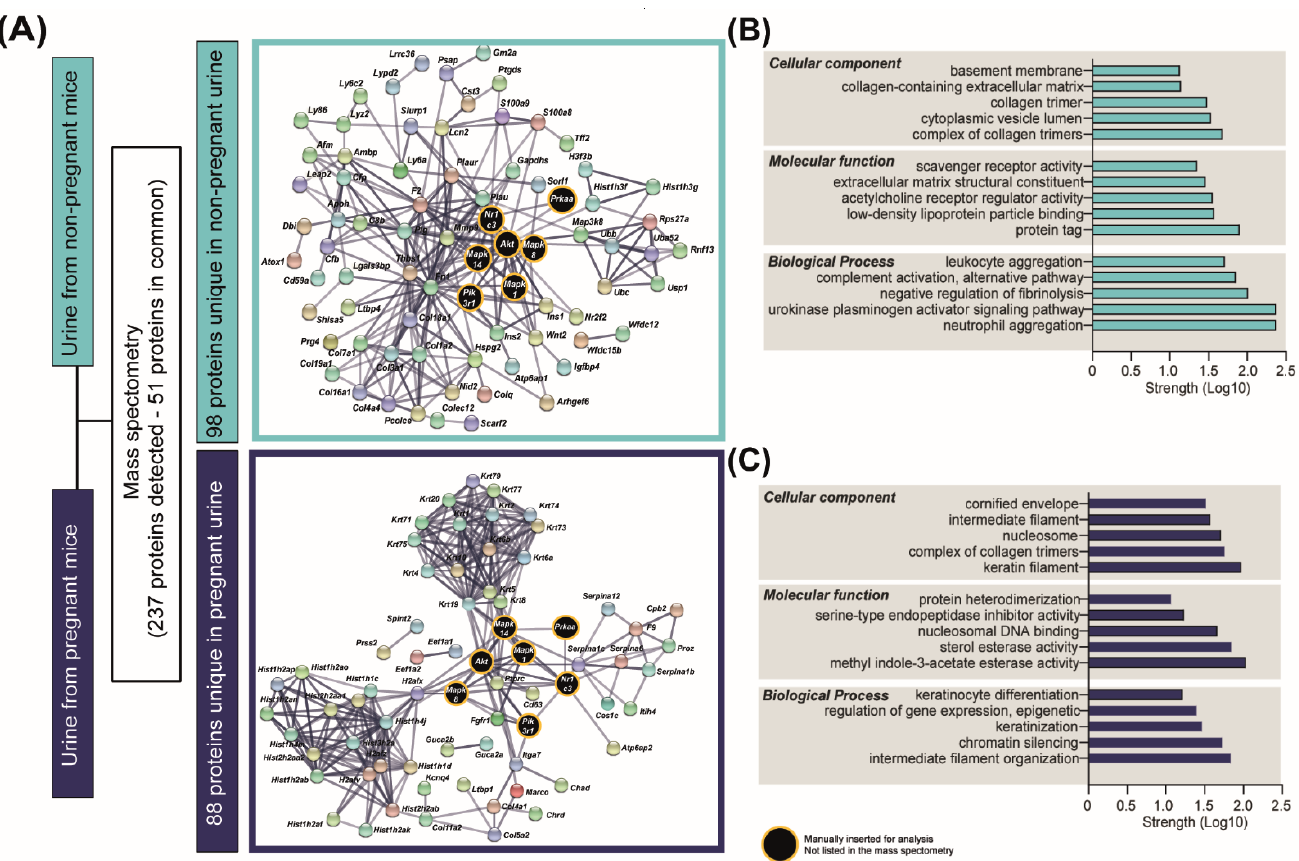
Figure 5. Urinary proteins detected in non-pregnant and pregnant mice. ( A ) Results of the analysis of proteins detected by mass spectrometry in urine samples ( n = 3/group). ( B , C ) Top-scoring cellular, molecular and biological processes for the 98 and 88 proteins uniquely detected in non-pregnant and pregnant urine, respectively. Network representation and pathway analysis were performed with STRING.